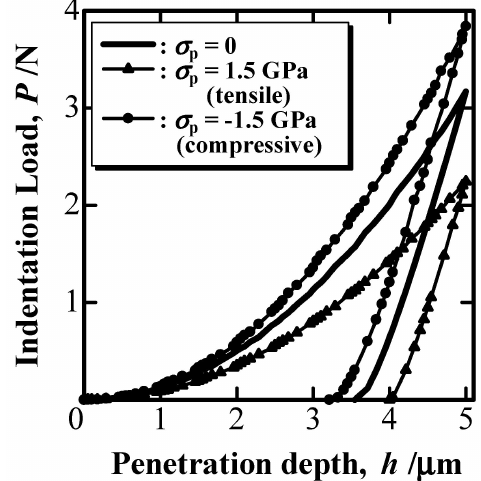
Figure 2. Simulated P–h curve affected by